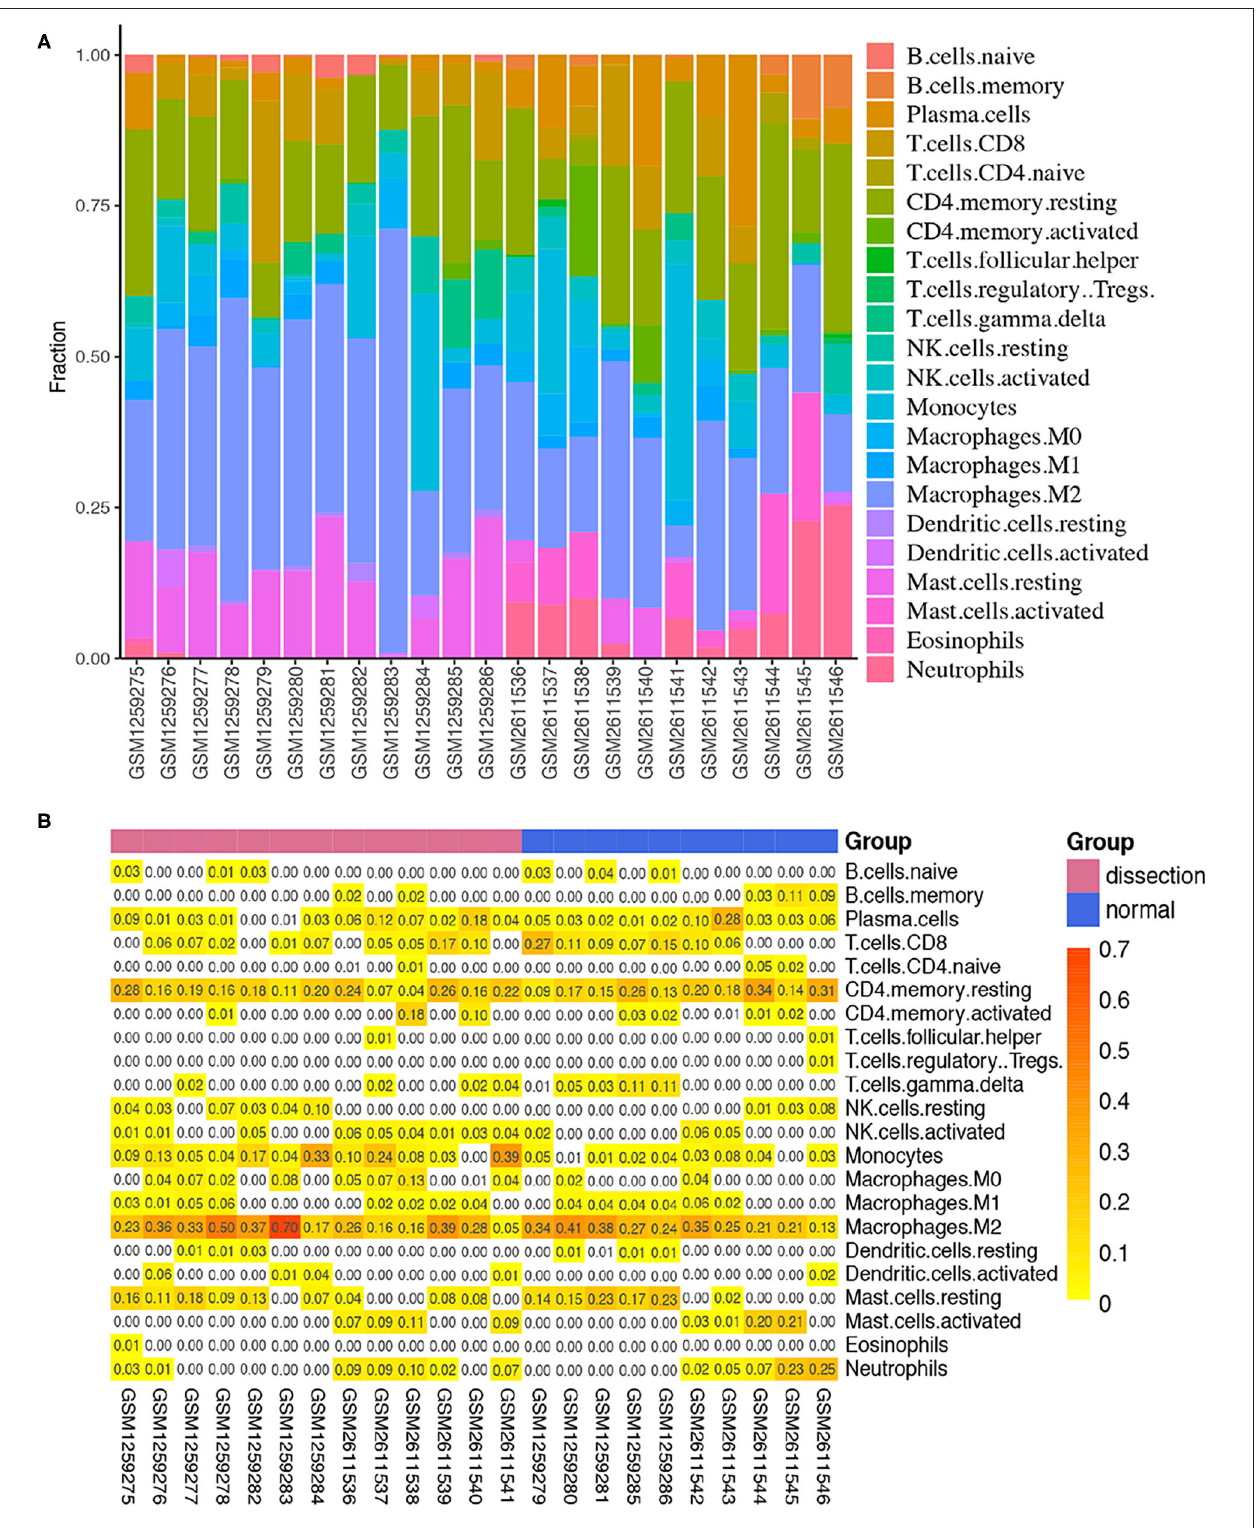
FIGURE 6 | Immune infiltration analysis in the training sets using CIBERSORT. (A) Histogram of the fraction of 22 types of immunity in each sample. (B) Heatmap of the contents of 22 types of immune cells in each sample.